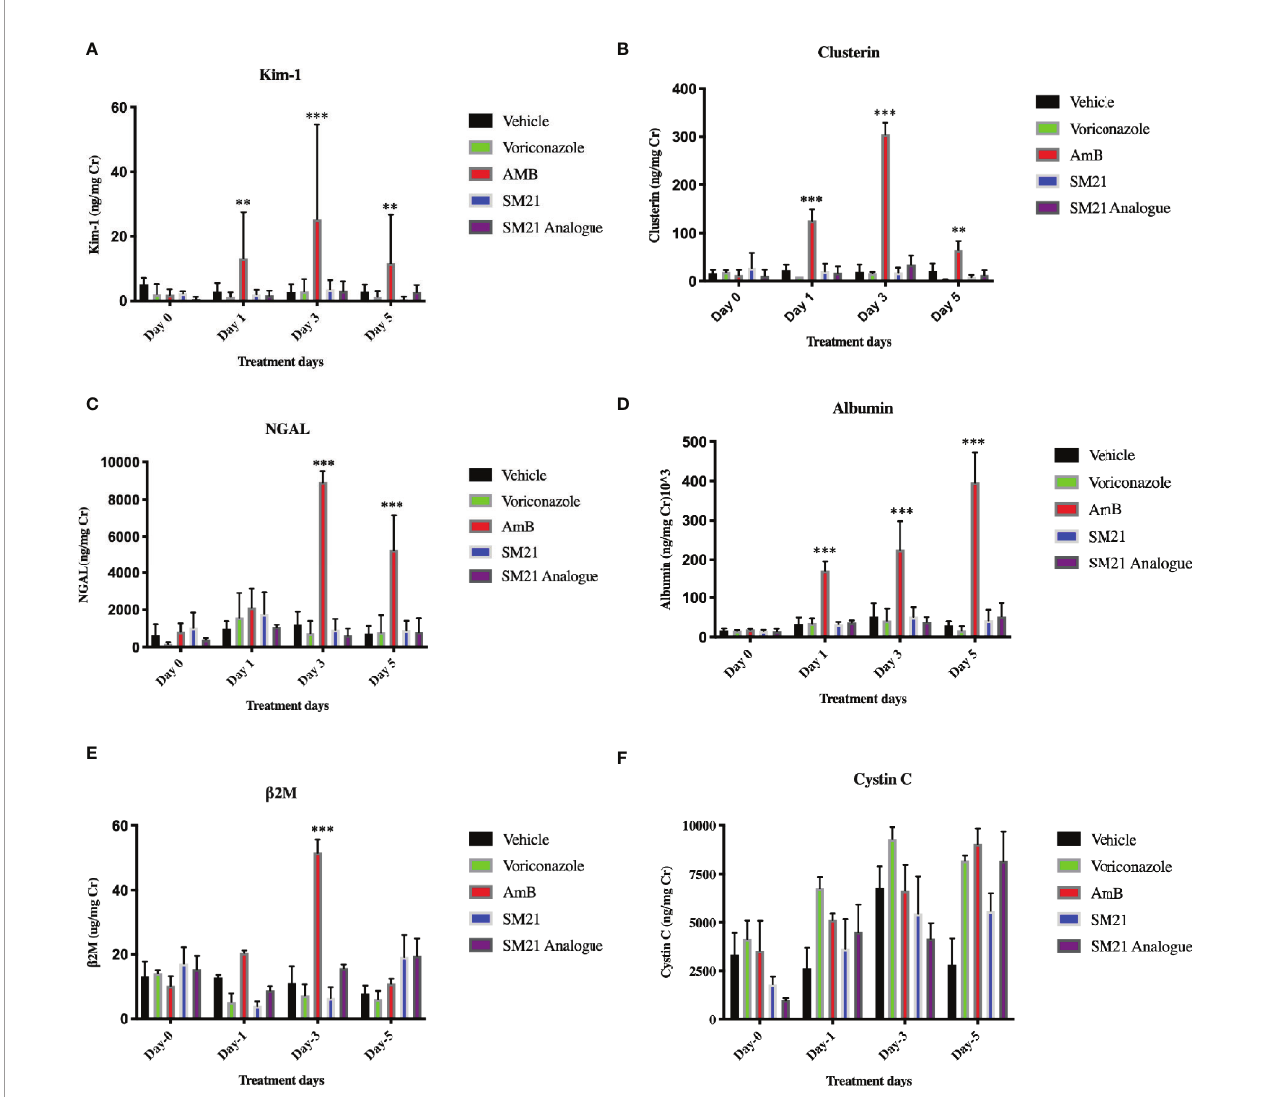
FIGURE 5 | Time course for the appearance of next generation urinary biomarkers . The urinary level of the biomarkers (A) Kim-1, (B) Clusterin , (C) NGAL (D) Albumin, (E) b 2M, (F) Cystin C before and after administration of AmB, Voriconazole, SM21 and SM21 Analogue in male SD rats at dose of 15 mg/kg/BW compared with vehicle-treated controls [n =9 for each treatment group except AmB group (n=7)]. Data are expressed as means ± SD. The statistical signi fi cance of differences between treated and control groups was determined using a repeated measures analysis, **p < .01, and ***p < .001 at each sampling point by ANOVA and Dunnett's test. The quantity of biomarkers in urine was presented after normalization, based on the concentration of urinary creatinine. Signi fi cant expression of Kim-1, NGAL, Clusterin, and Albumin were observed with AmB at day 1 & 3. In contrast, the expression of these biomarkers in SM21 and its analogue were not statistically signi fi cant compared to vehicle (saline) and voriconazole groups. Kim-1, Kidney injury molecule-1; NGAL, Neutrophil gelatinase-associated lipocalin; b 2M, b macroglobulin; AmB, Amphotericin